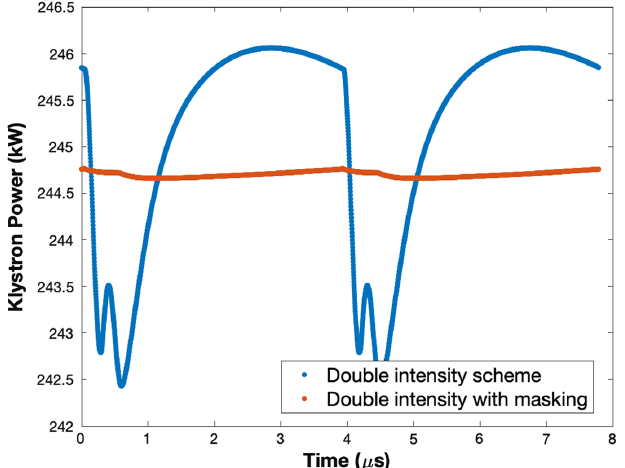
FIG. 15. Klystron output power with and without error signal